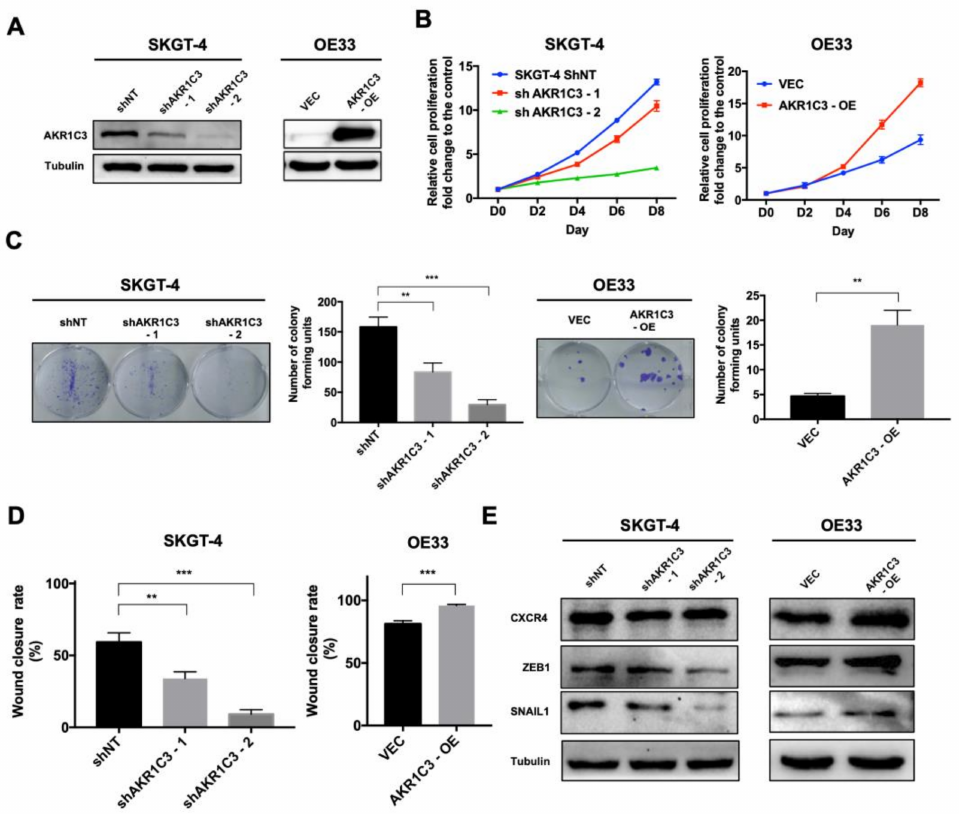
Figure 2. AKR1C3 promotes proliferation, colony formation and migration of EAC cells. ( A ) Valida- tion of stable knockdown of AKR1C3 in SKGT-4 cells and overexpression of AKR1C3 in OE33 cells. ( B ) Proliferation rates, ( C ) colony forming capacity and ( D ) migration capacity of SKGT-4 shAKR1C3 cells, OE33 AKR1C3 overexpressing cells and their respective control cells were examined. ( E ) West- ern blot results showed that the expression levels of CXCR4, ZEB1 and SNAIL1 were downregulated when AKR1C3 was knocked down in SKGT-4 cells, but these markers did not significantly increase when AKR1C3 was overexpressed in OE33 cells. Data are presented as mean ± SD ( n = 3). ** p < 0.01, *** p <